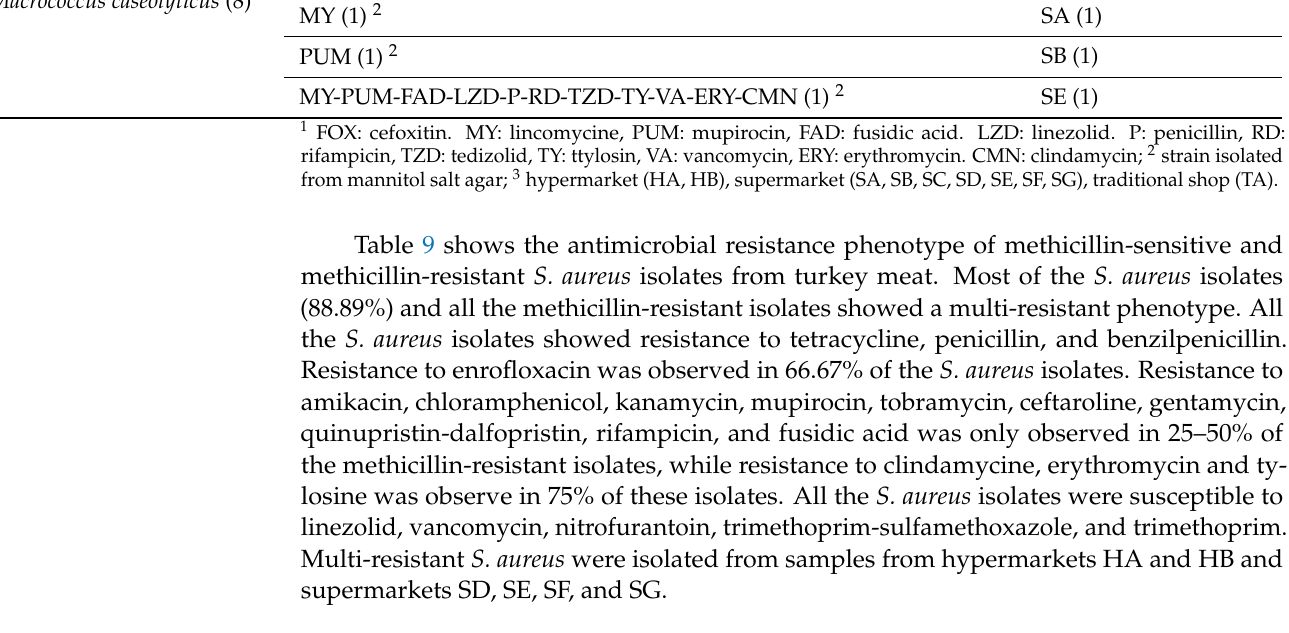
Macrococcus caseolyticus (8)